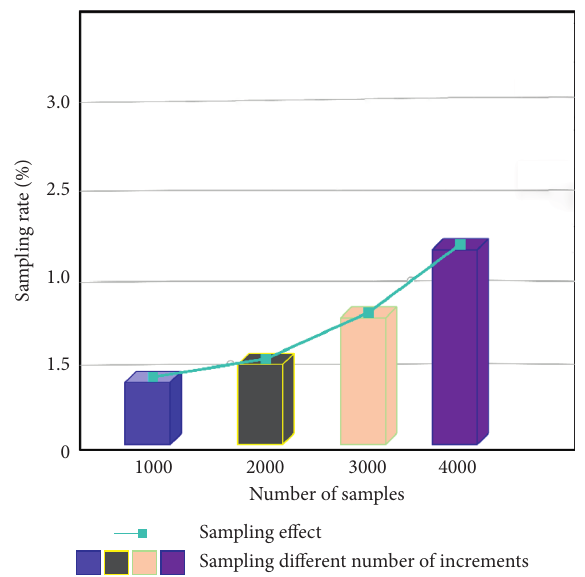
Figure 9: Large-scale different data sampling and processing rate diagram.